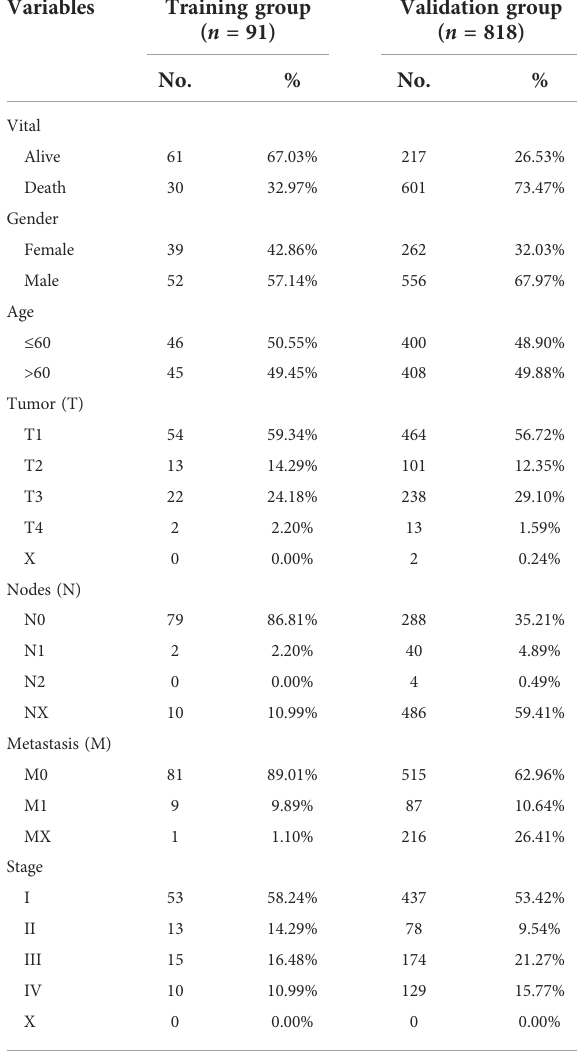
TABLE 1 Clinical features of patients with kidney